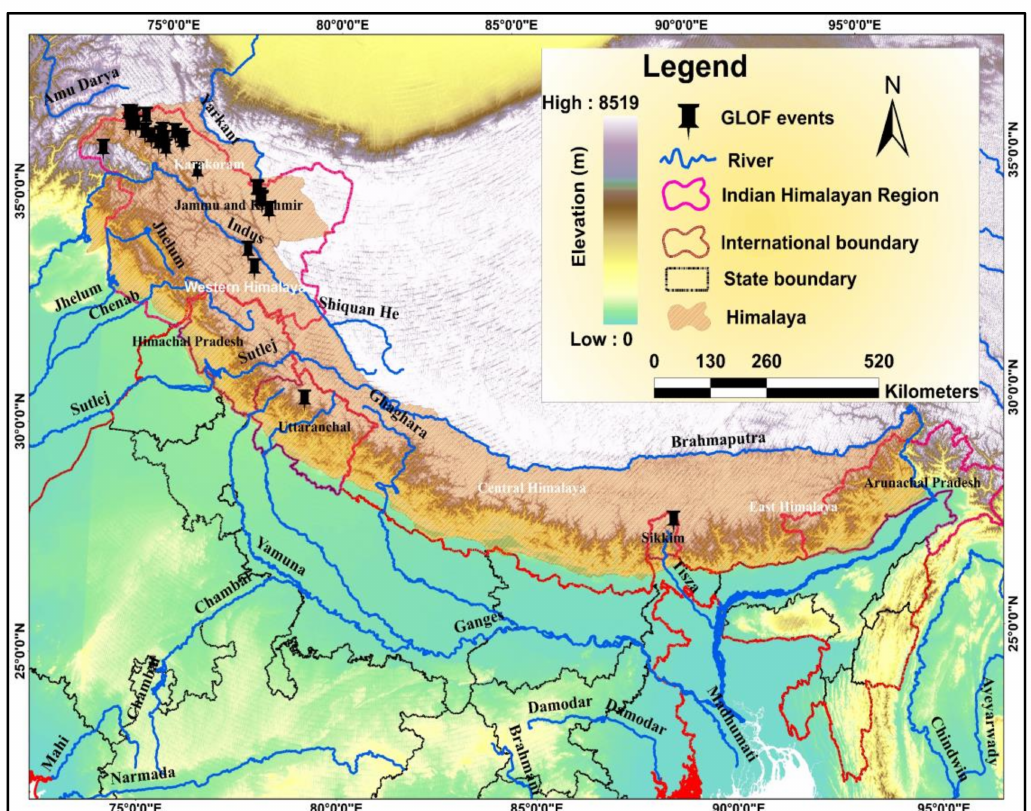
Figure 1. Distribution of GLOF events reported in the India Himalayan